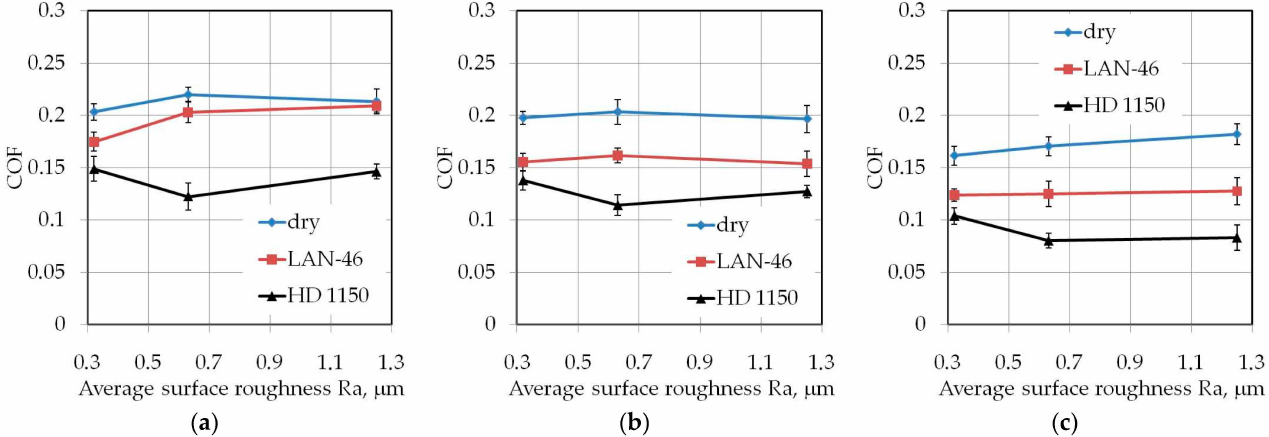
Figure 10. Effect of countersample roughness on the value of COF for specimens with a width of w = 7 mm cut along the rolling direction (orientation 0 ◦ ): ( a ) h = 6 mm, ( b ) h = 12 mm, ( c ) h = 18 mm.